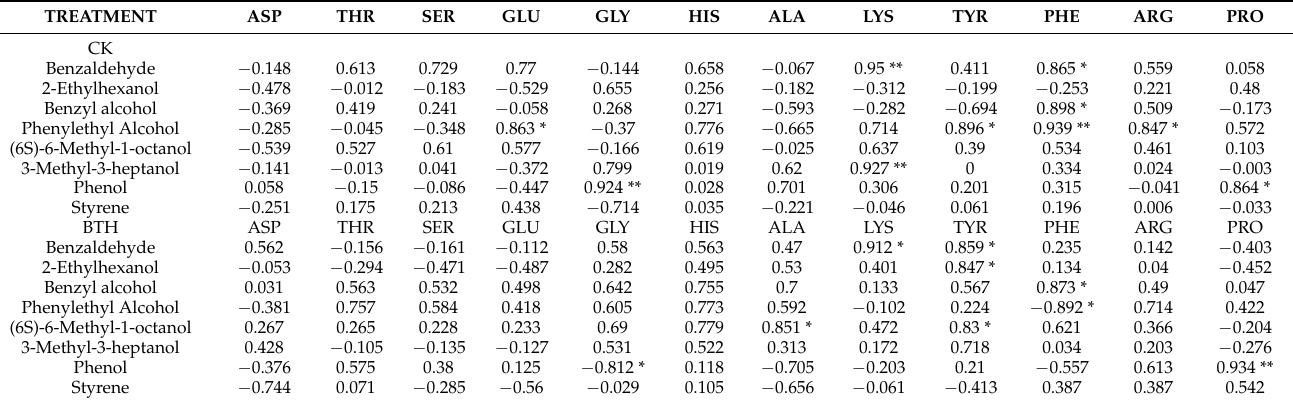
Table 2. Correlation coefficients between amino acids and derived volatile compounds from untreated (CK) and treated (BTH) Cabernet Gernischt cv grapes at harvest. TREATMENT